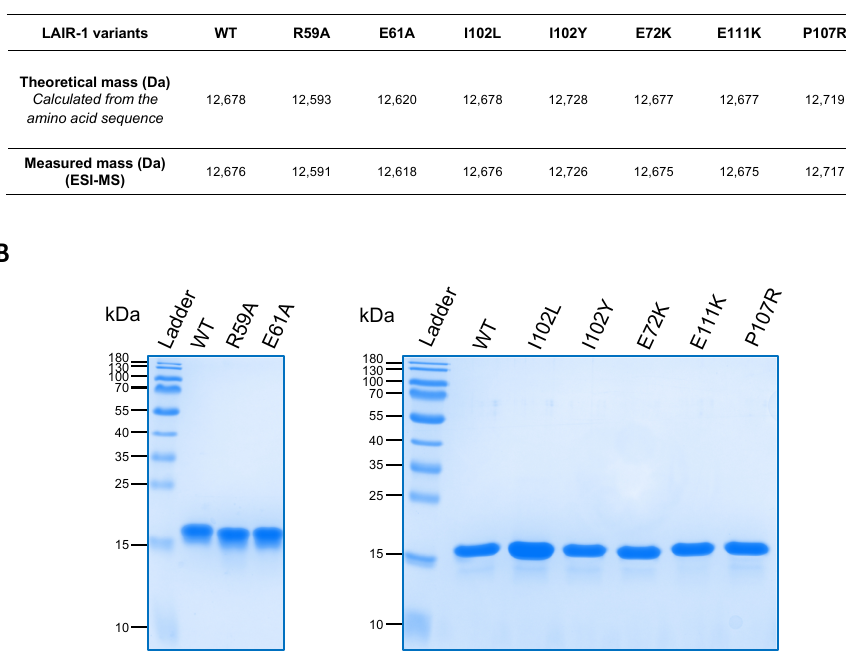
Figure 1. Quality control of the LAIR-1 Ig-like domain variants. ( A ) Summary table of the the- oretical masses calculated from the amino acid sequences and the measured masses by ESI-MS experiments of the LAIR-1 variants produced. ( B ) SDS-PAGE analysis of the LAIR-1 variants on a 14% polyacrylamide gel under reducing condition.